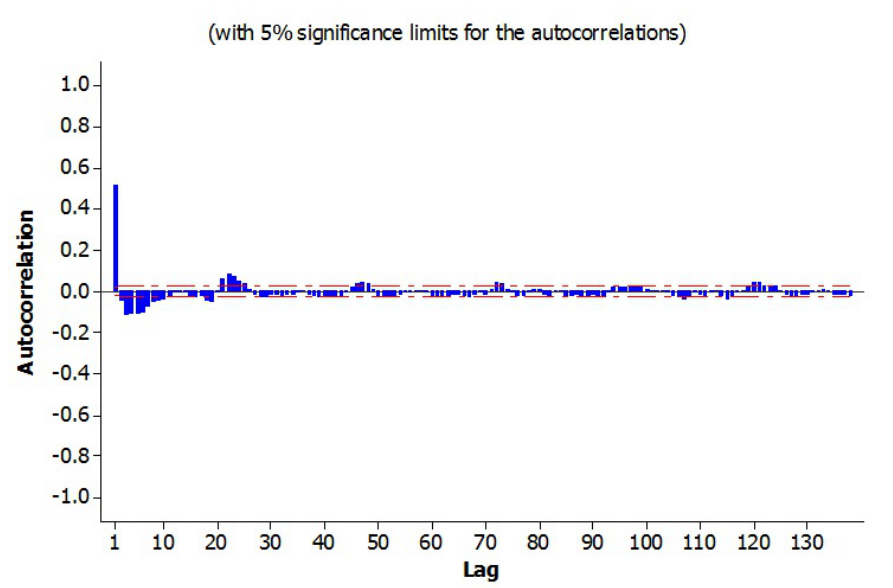
Figure 8. Autocorrelation function of the stationary